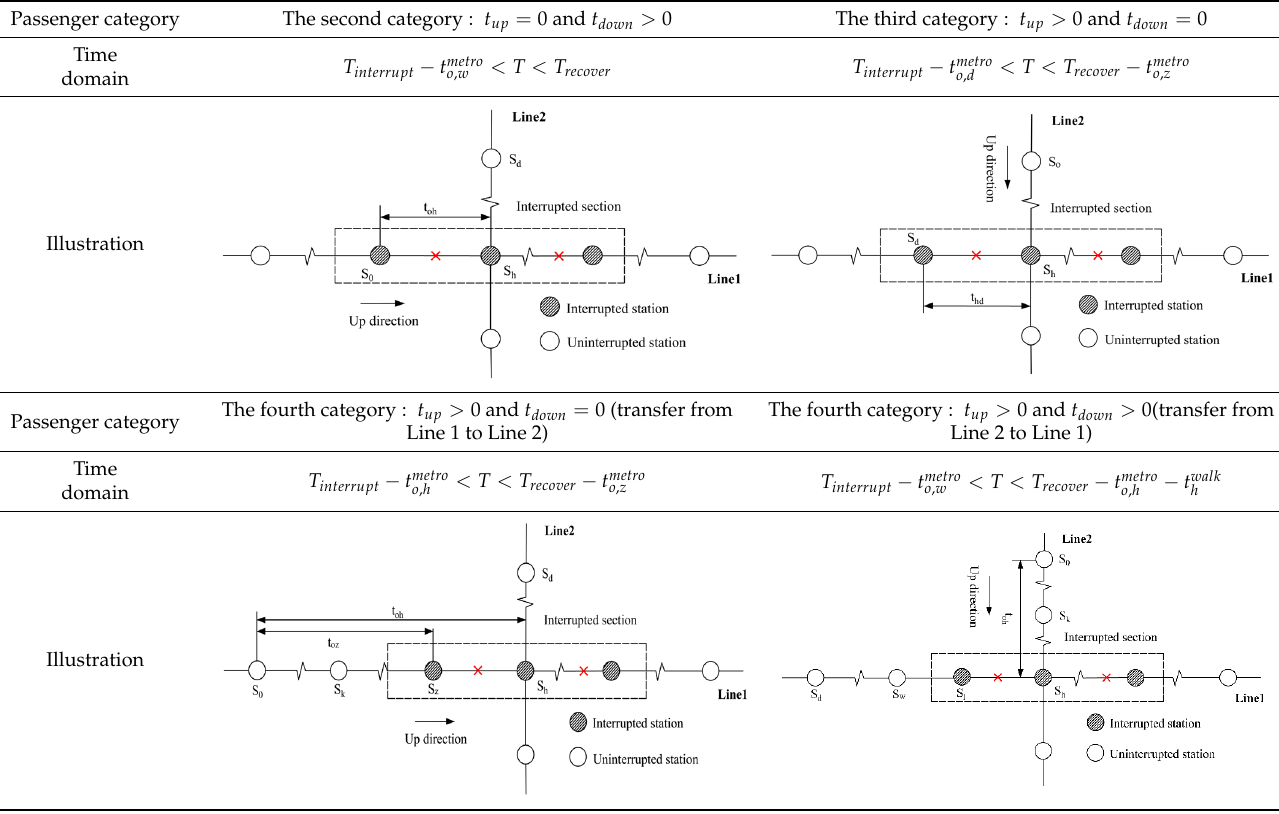
Table 2. The tap-in time domains of affected transfer passengers.